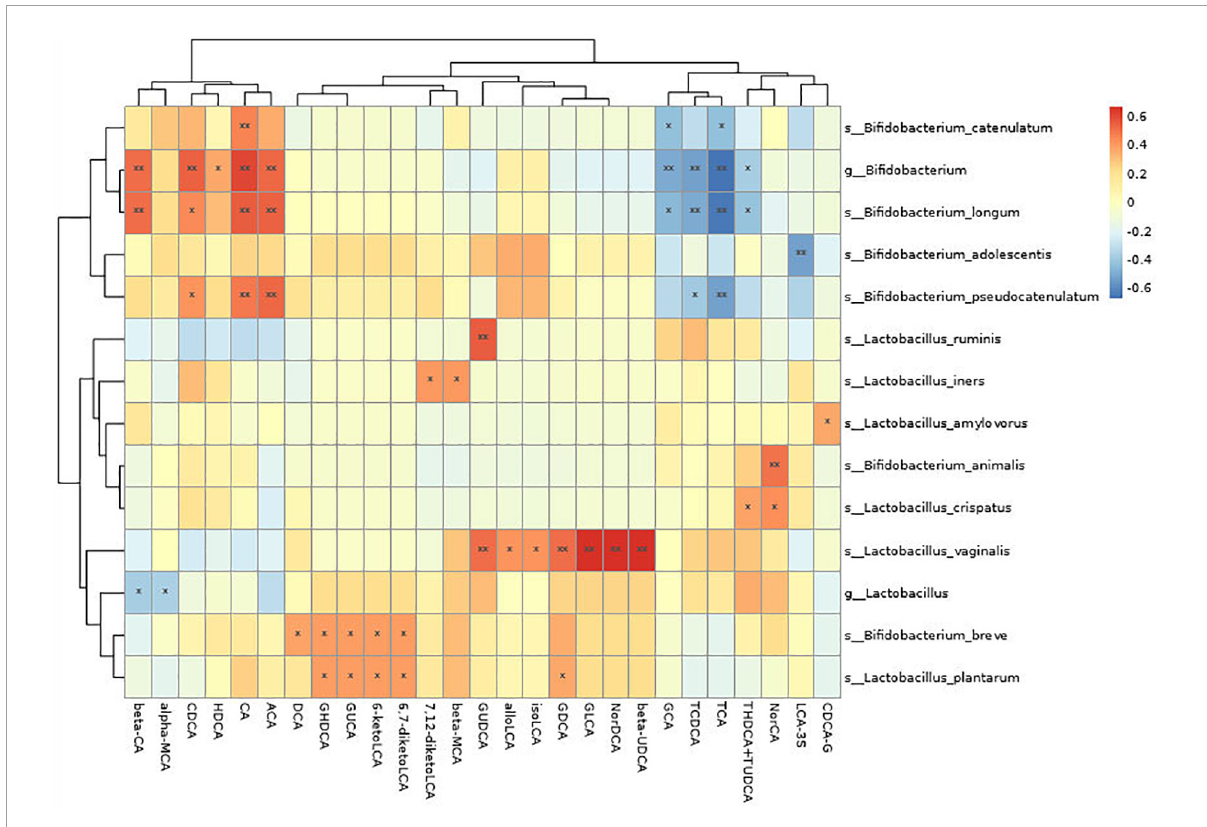
FIGURE3 Correlation analysis between probiotic species and bile acid metabolism indexes.